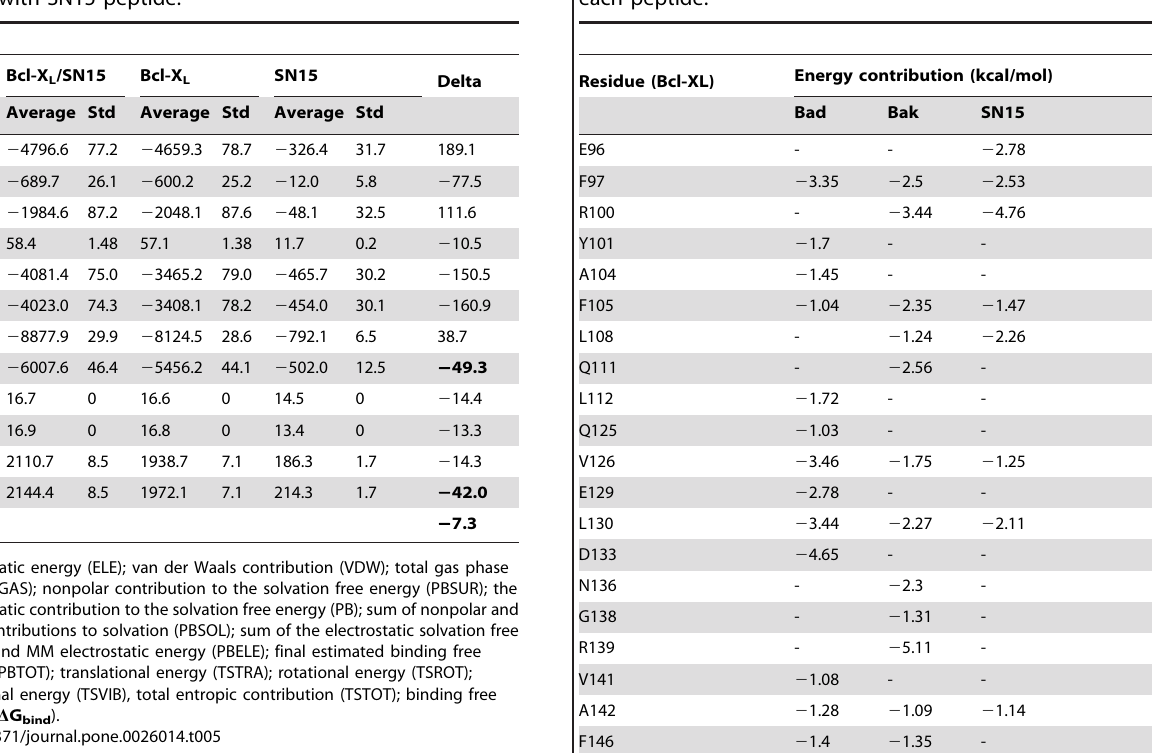
Table 6. Bcl-X L residues and their energy contribution for each peptide.